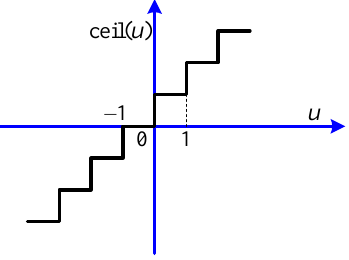
Figure 4. Ideal functions ceil of the proposed AAVE method.